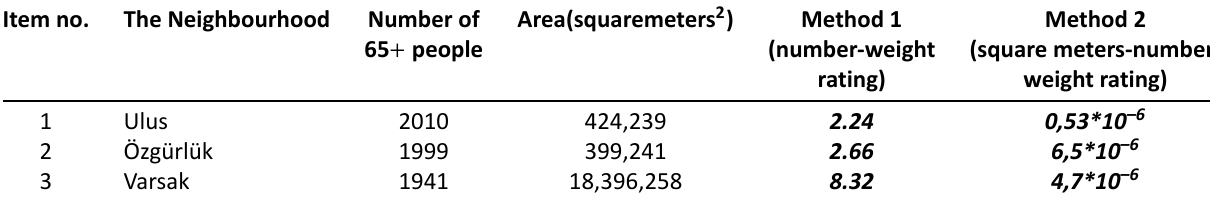
Table 7. Results of AHP analysis based on 65+ ratio and area size. Item